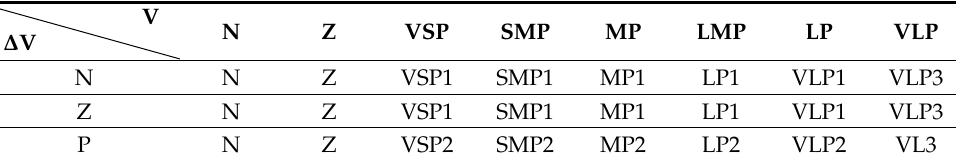
Figure 14. Output membership function. Table 1. Rule base for fuzzy logic